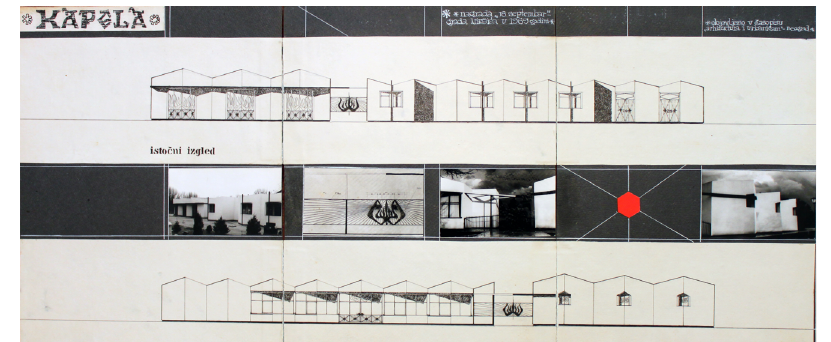
Groundfloor and section of the